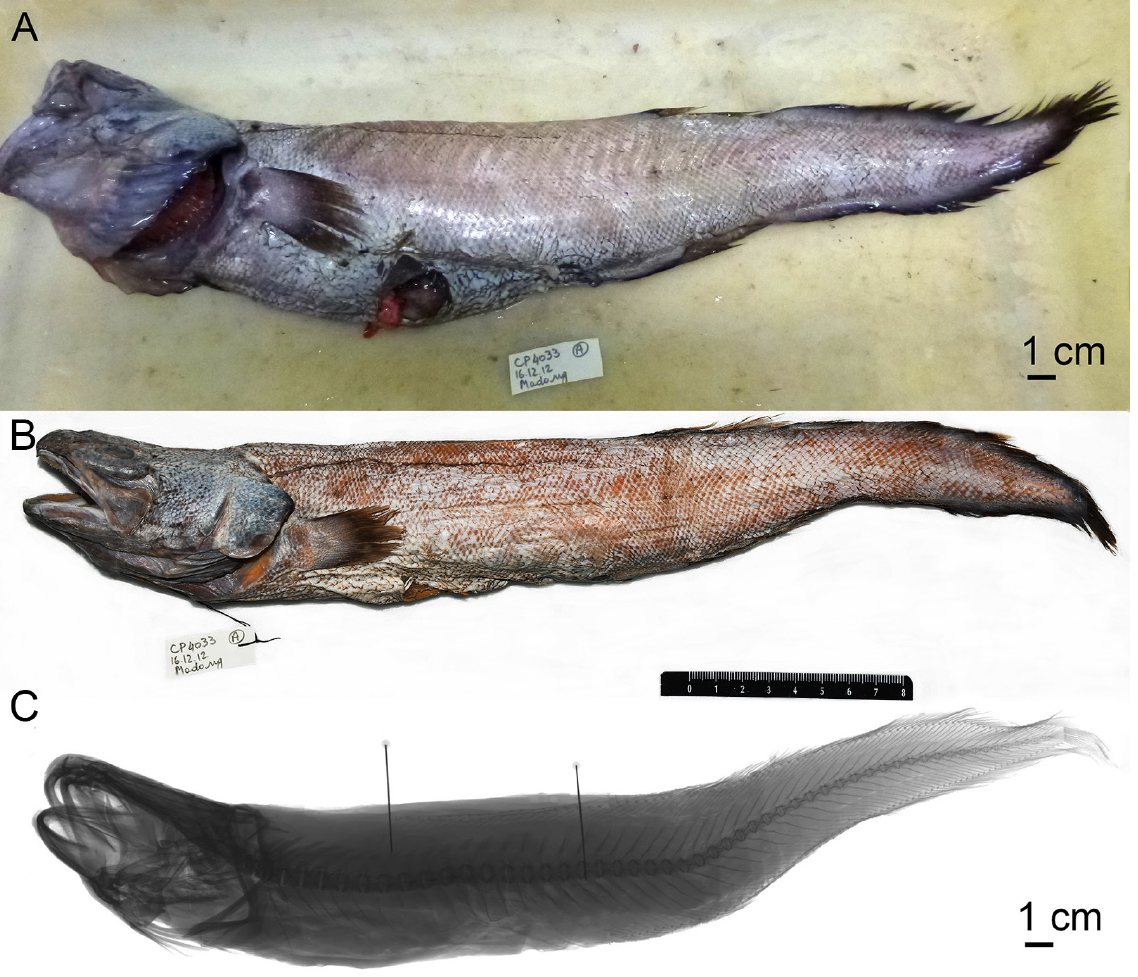
Fig. 5. Luciobrotula bartschi Smith & Radcliffe 1913. Voucher specimen, 393.7 mm